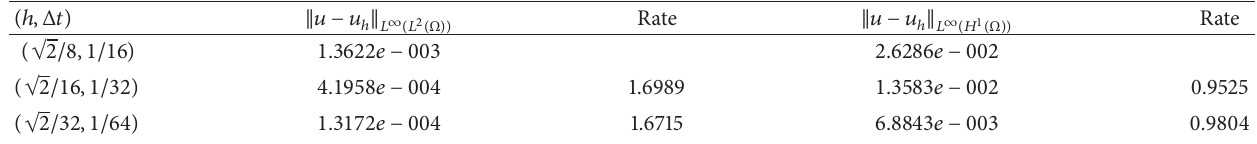
Table 1: The errors and convergence rate for 𝑢 .